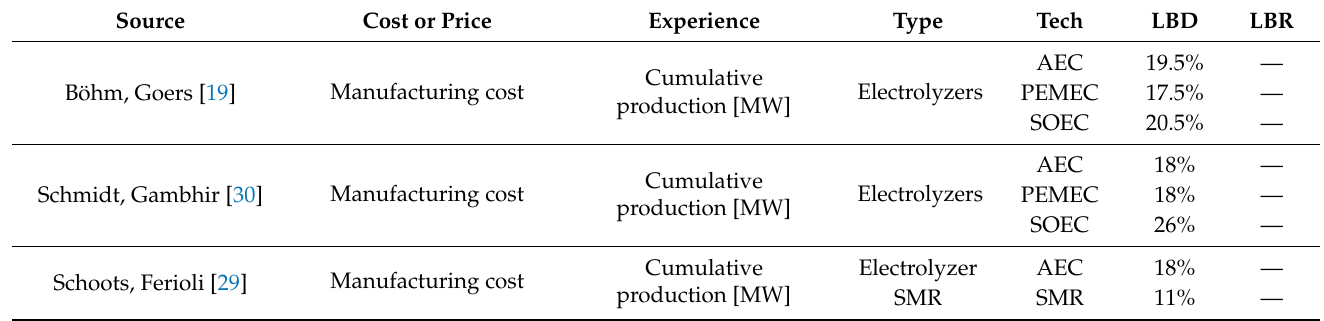
Table A5. LRs for hydrogen